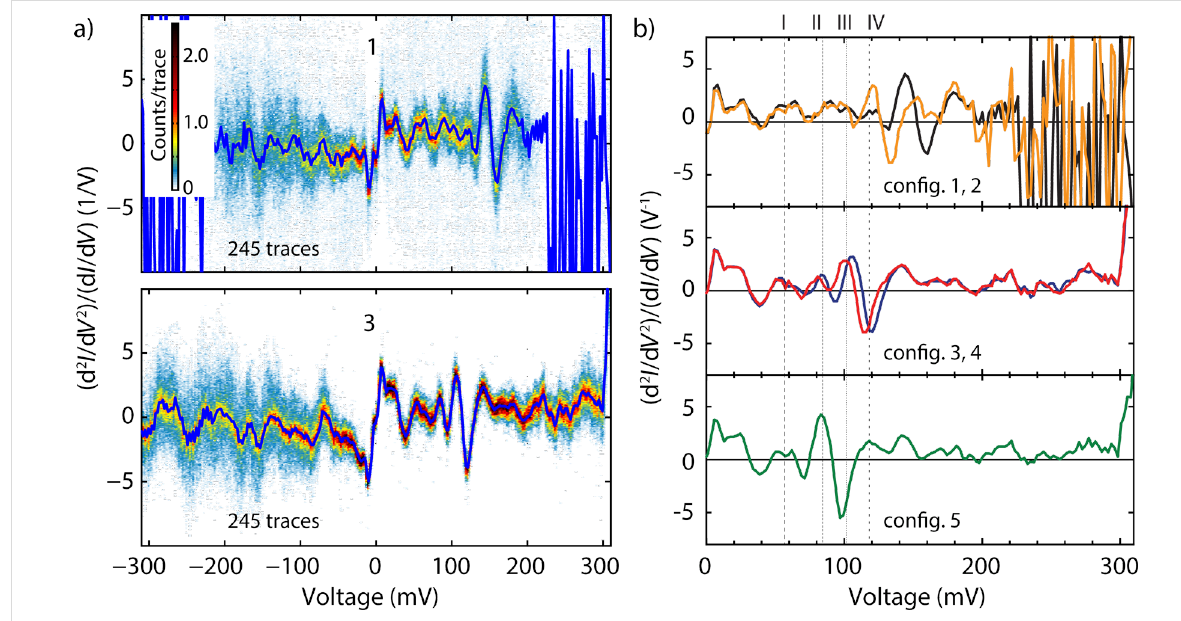
Figure 3: (a) Two-dimensional histograms of two configurations built from the individual spectra measured on OPE3. The histograms are built from all the individual second derivative traces by binning the x-axis with 600 bins/V and the y-axis with 12 bins/(1/V). (b) Master-curves of the spectra for the five junction configurations extracted from the two-dimensional histograms. The colors used in (b) correspond to the different junction configurations 1–5.